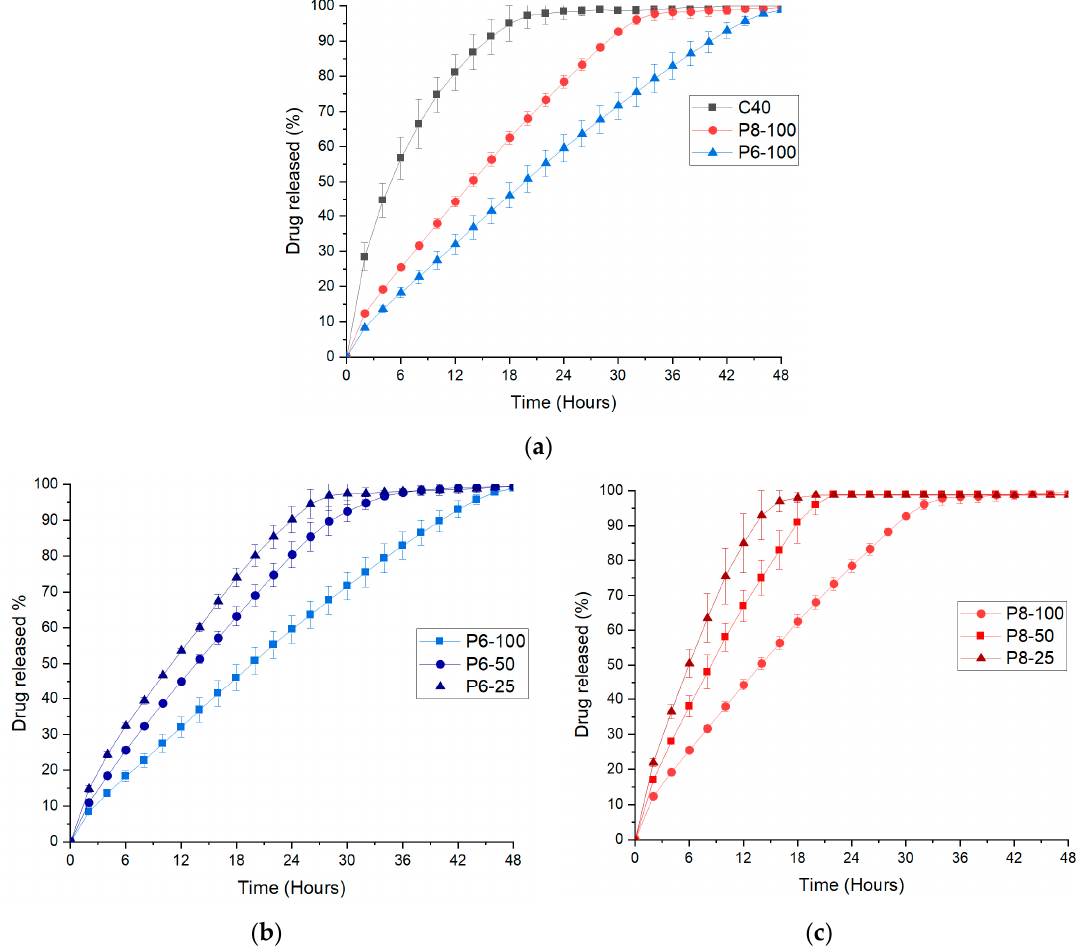
Figure 9. ( a ) Dissolution profiles of the core only (C40), compared with P6-100 and P8-100; ( b ) dissolution profiles of P6-100, P6-50, and P6-25; ( c ) dissolution profiles of P8-100, P8-50, and P8-25.